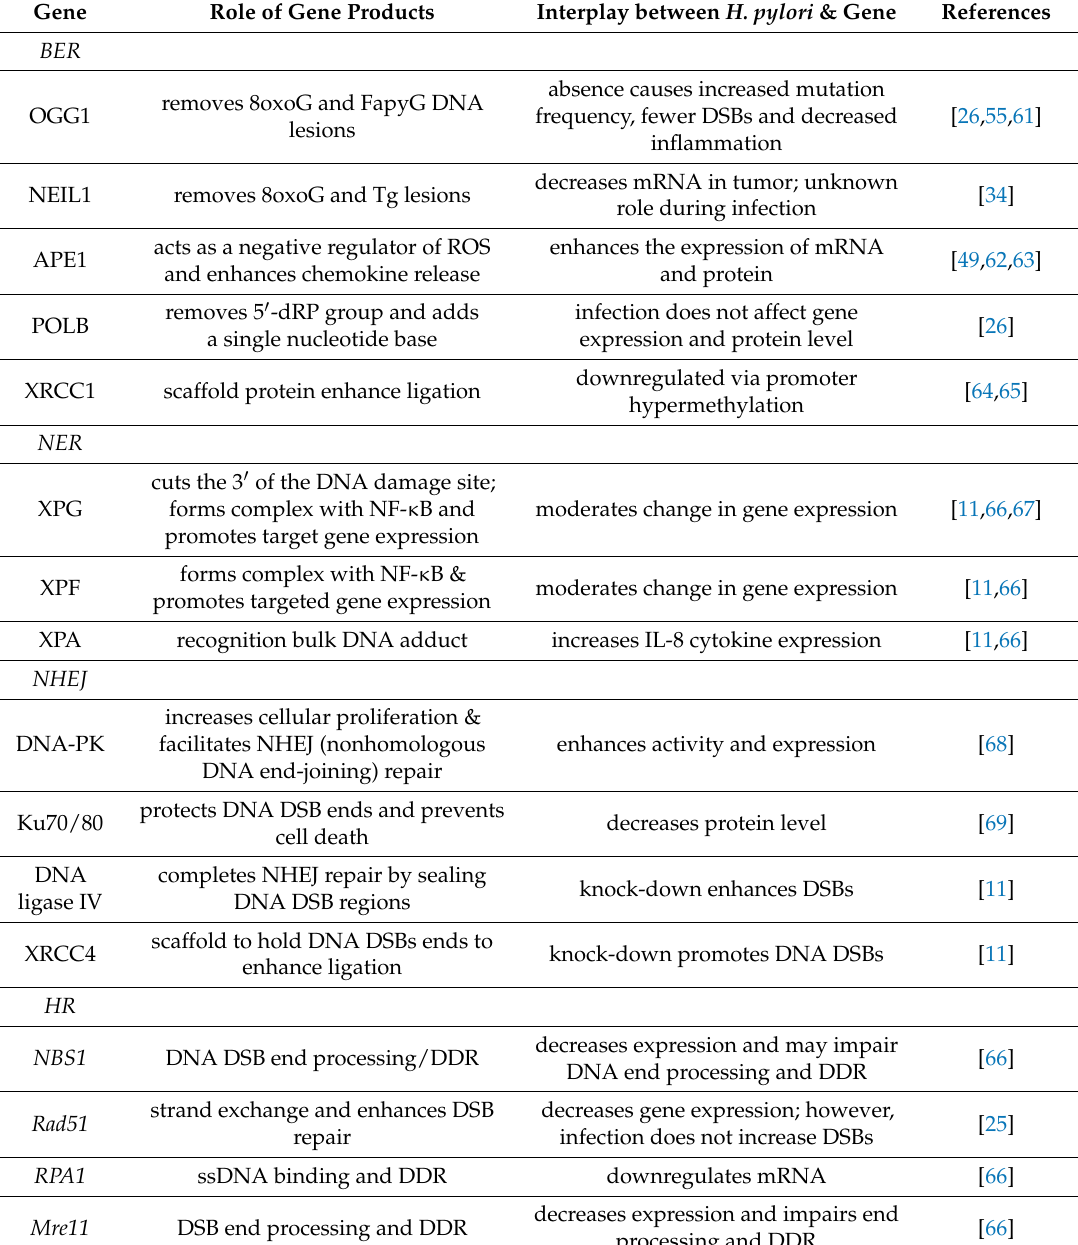
Table 1. Interplay between H. pylori and relevant DNA repair gene